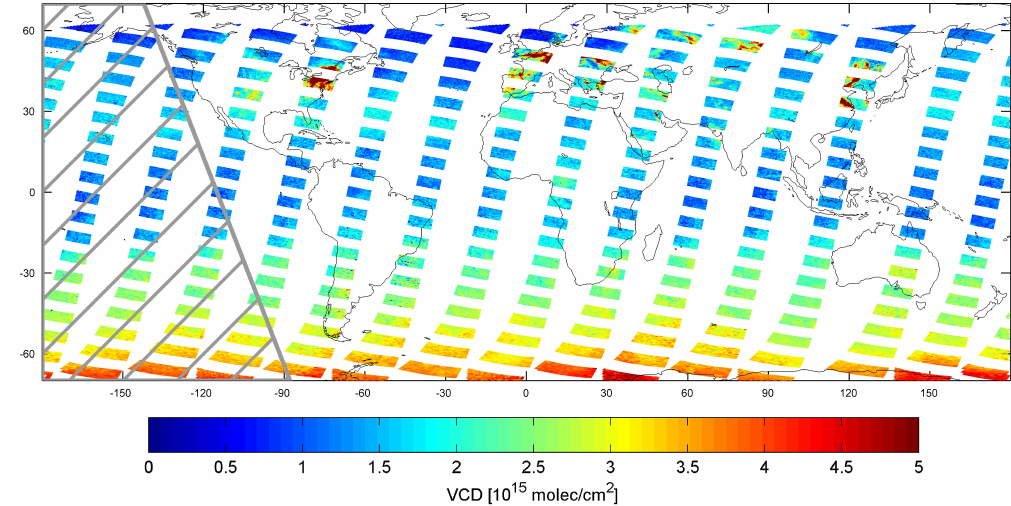
Fig. 1. Nadir VCD V ∗ for 28 January 2006. The marked area in the Pacific is the reference sector used in this